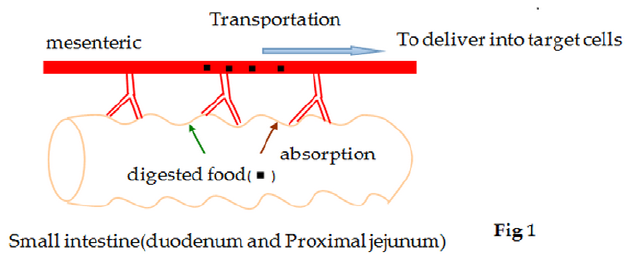
Figure 1. Absorption of digested food (glucose) from the intestinal lumen into the blood, and transportation of the absorbed nutrients via mesenteric circulation to target